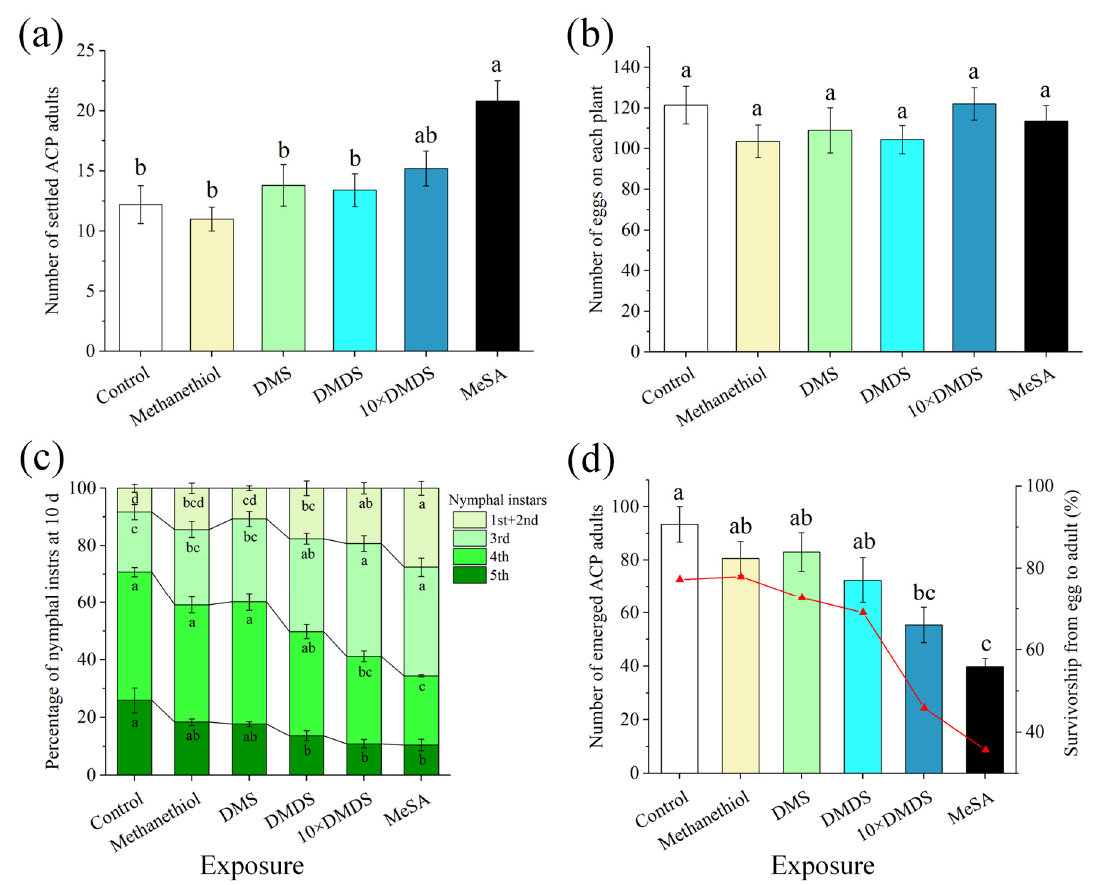
Figure 2. Exposure of sweet orange plants to sulfur volatiles affected the host selection behavior and population development of Asian citrus psyllid (ACP). ( a ) The number of settled ACP adults at 24 h after their release in wind tunnels. ( b ) The number of eggs on each plant after ACP oviposition for 48 h. ( c ) The percentage of nymphal instars at 10 d after ACP release for oviposition. ( d ) The number of total emerged adults (columns) and the rate of survivorship (dotted line) from egg to adult. Data are shown as means ± SE ( n = 5). Different letters on the columns indicate significant differences among the different treatments based on Tukey’s test ( p <